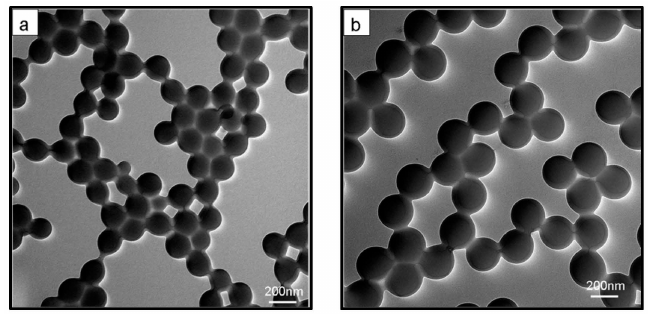
Figure 6. TEM micrographs of the final particles prepared by emulsion polymerization of styrene using methanol solution (20/80 w / w ) as the polymerization medium and various initiator systems: ( a ) AIBN and ( b ) AIBA. The TEM micrograph of the final particles prepared by emulsion polymerization of styrene initiated by KPS is shown in Figure 1b.